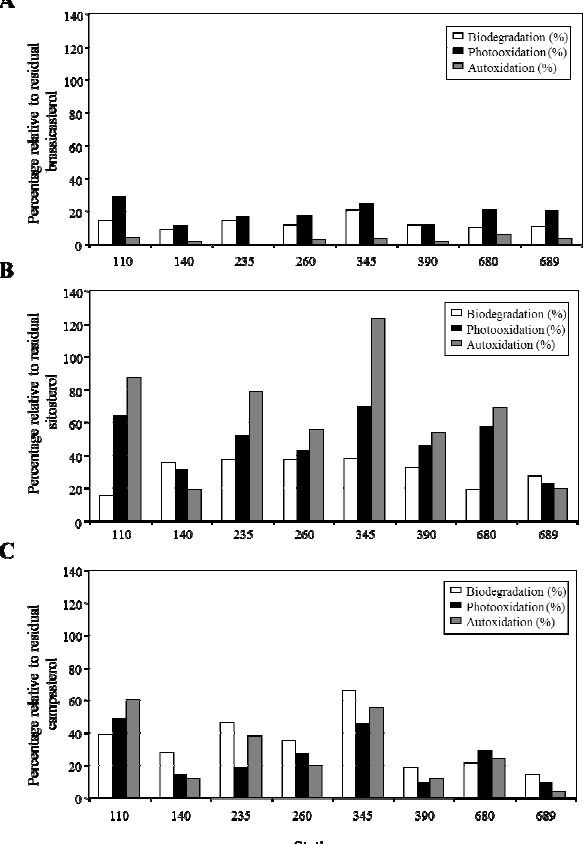
Fig. 5. Estimates of relative autoxidation, photooxidation and epox- ide production (as percentages relative to the residual parent com- 46 Fig. 4. Estimates of relative biodegradation, autoxidation and pho- pound) (A) and trans / cis ratio measured (B) of vaccenic acid for tooxidation (as percentages relative to the residual parent com- the different sediments pound) of brassicasterol (A) , sitosterol (B) and campesterol (C) for the different sediments investigated.